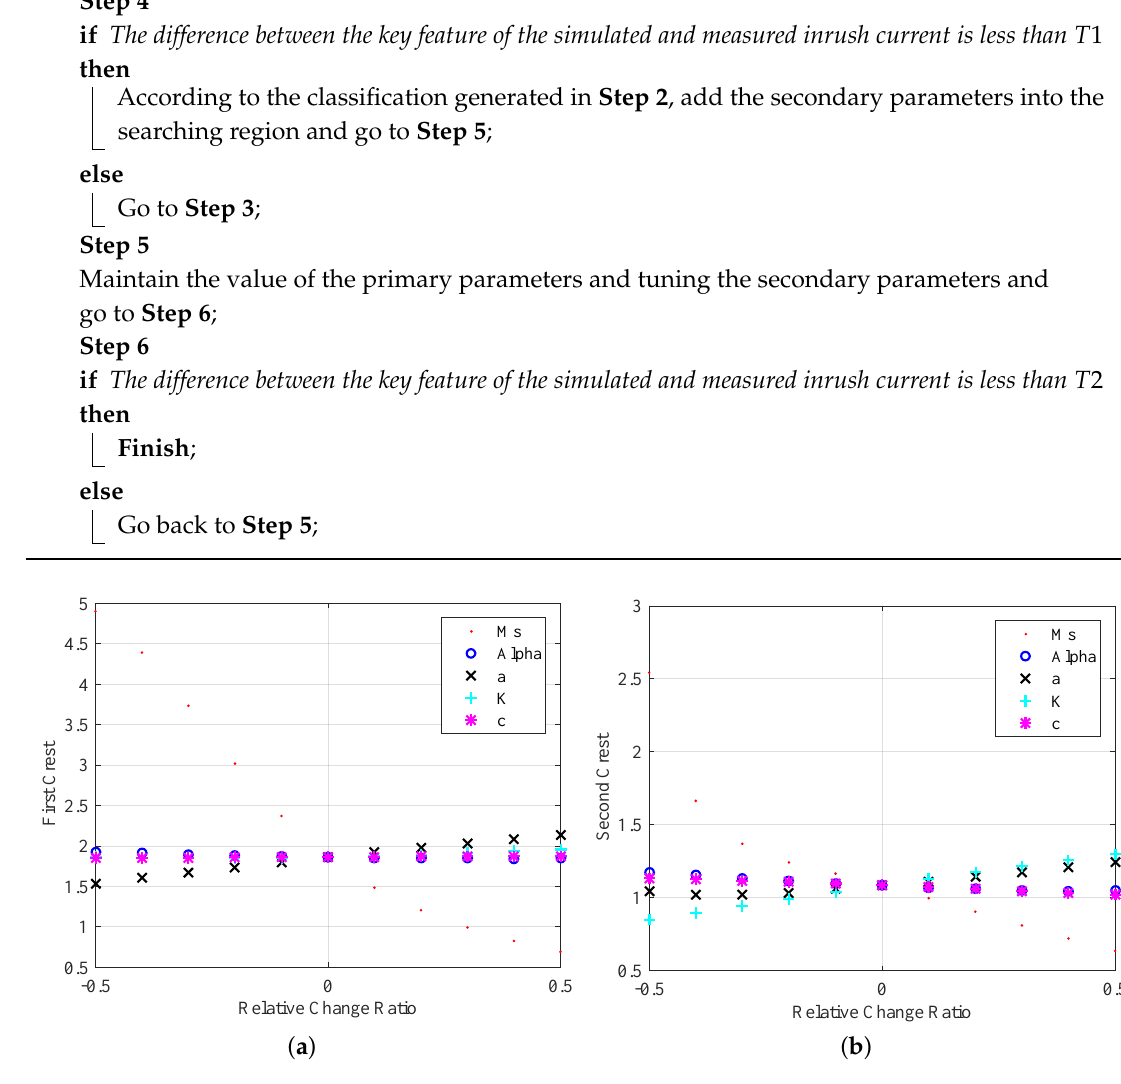
Figure 6. Impact of the J–A parameters on ( a ) the first crest; ( b ) the second